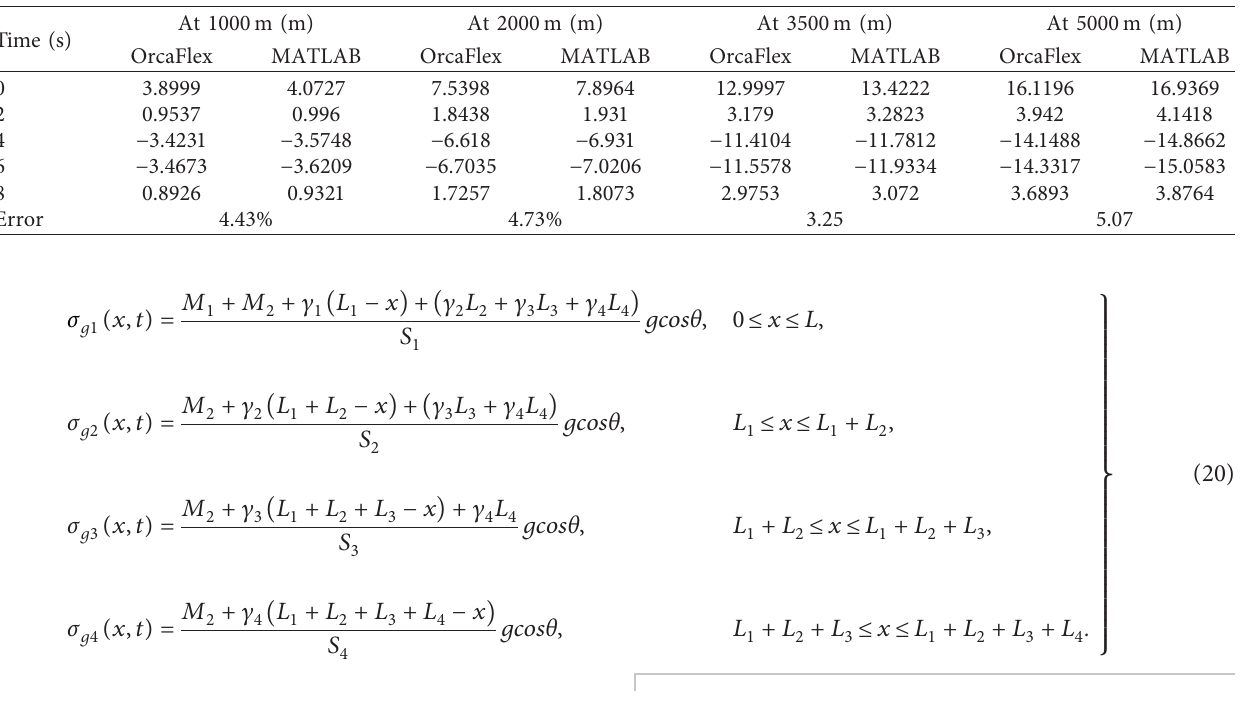
Table 4: Longitudinal vibration displacements of lifting pipe at different